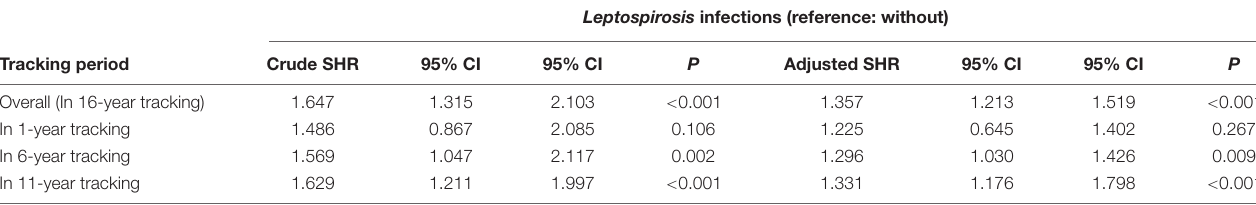
TABLE 6 | Factors of dementia by using Fine and Gray’s competing risk model.